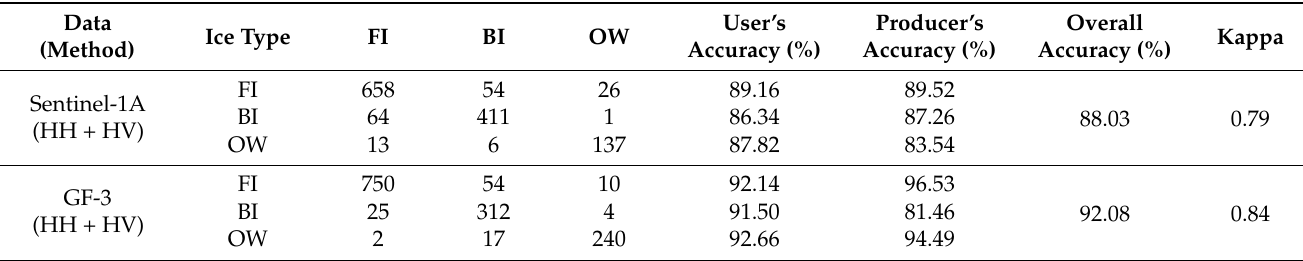
Table 5. Sea ice classification confusion matrix for the Sentinel-1A scene of the R3-15 scene and the GF-3 R3-15 scene based on